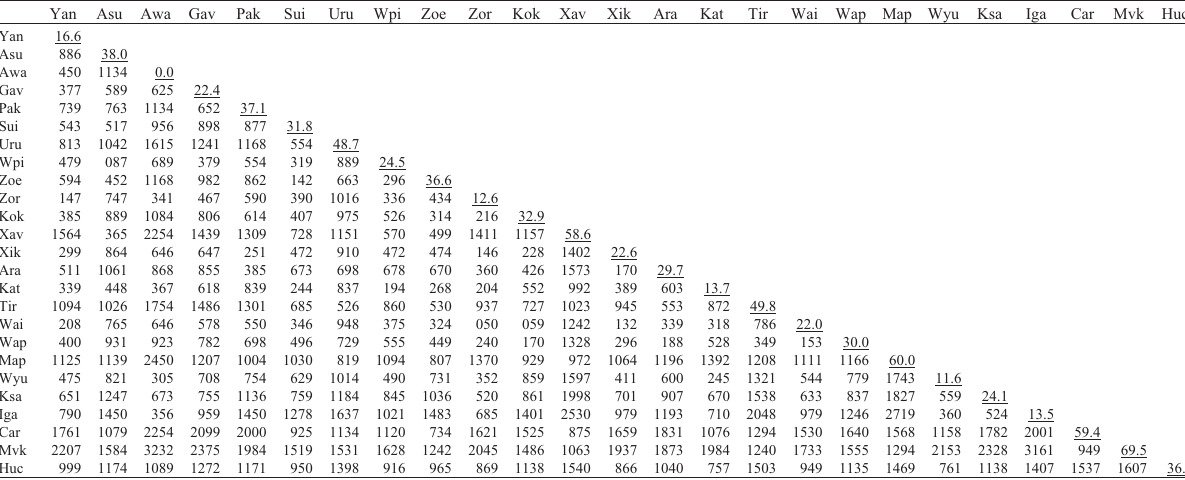
Table 3 - Heterozygosity (x100) and genetic distances (DA) between Amerindian tribes based on β -globin haplotypes (X 10,000).